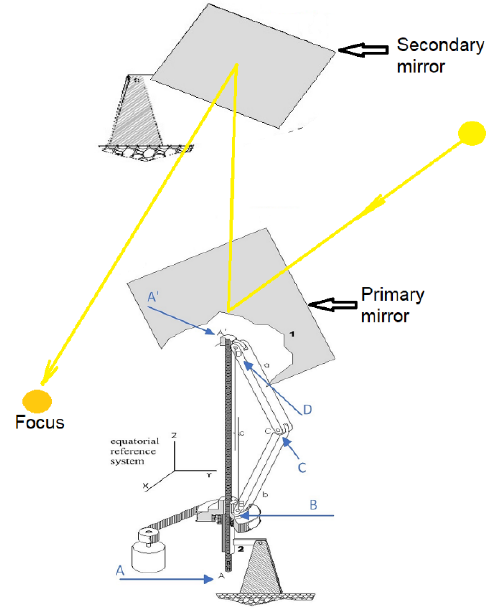
Figure 5. Polar heliostat prototype used for the proposed daylighting system.